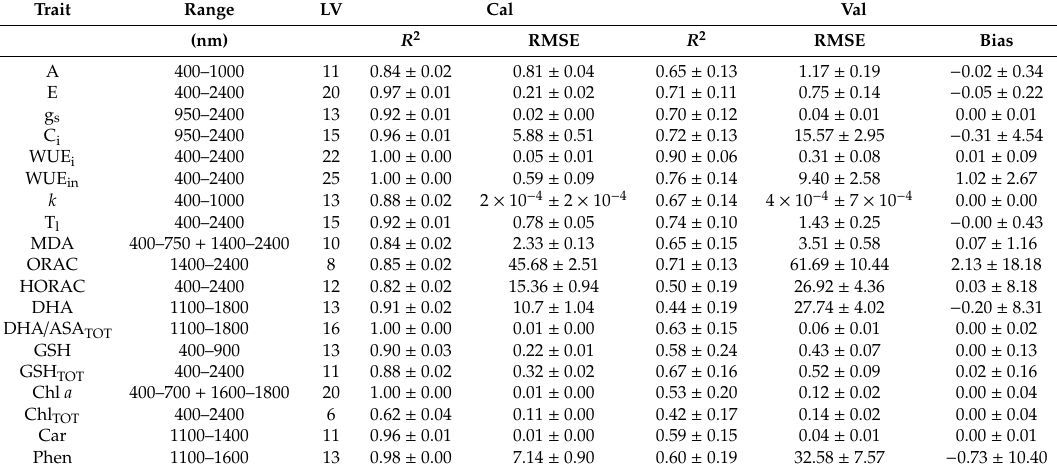
Table 1. Range, number of latent variables (LV), and model goodness-of-fit ( R 2 ), root mean square error (RMSE), and bias for calibration (cal) and validation (val; i.e., root-mean square error for prediction) data generated using 500 random permutations of the data with 80% used for cal and 20% used for val for PLSR-models predicting leaf traits from sage spectra. Data are shown as mean ± standard deviation. Bias for cal is not shown as it was always < 0.001. Trait abbreviations: A, CO 2 assimilation rate ( µ mol m − 2 s − 1 ); E, transpiration (mmol m − 2 s − 1 ); g s , stomatal